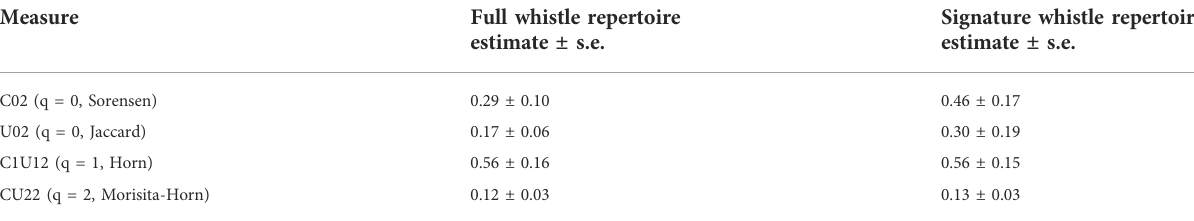
TABLE 5 Estimated similarity indices for comparing classic richness-based similarity and whistle relative abundances. Measure Full whistle repertoire estimate ±